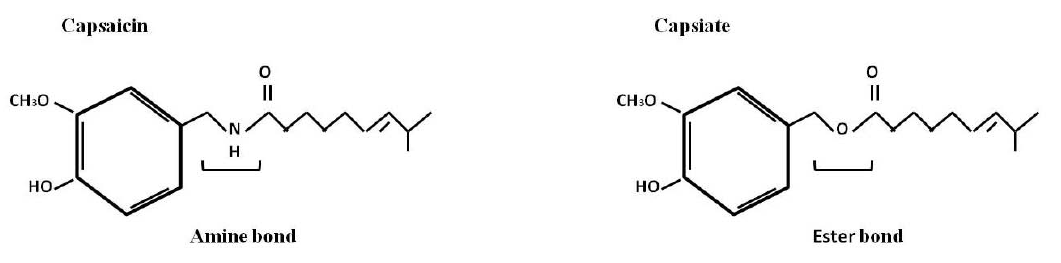
Figure 4. Structures of capsaicin and capsiate. Capsiate has an ester bond, whereas capsaicin has an amide bond at the equivalent